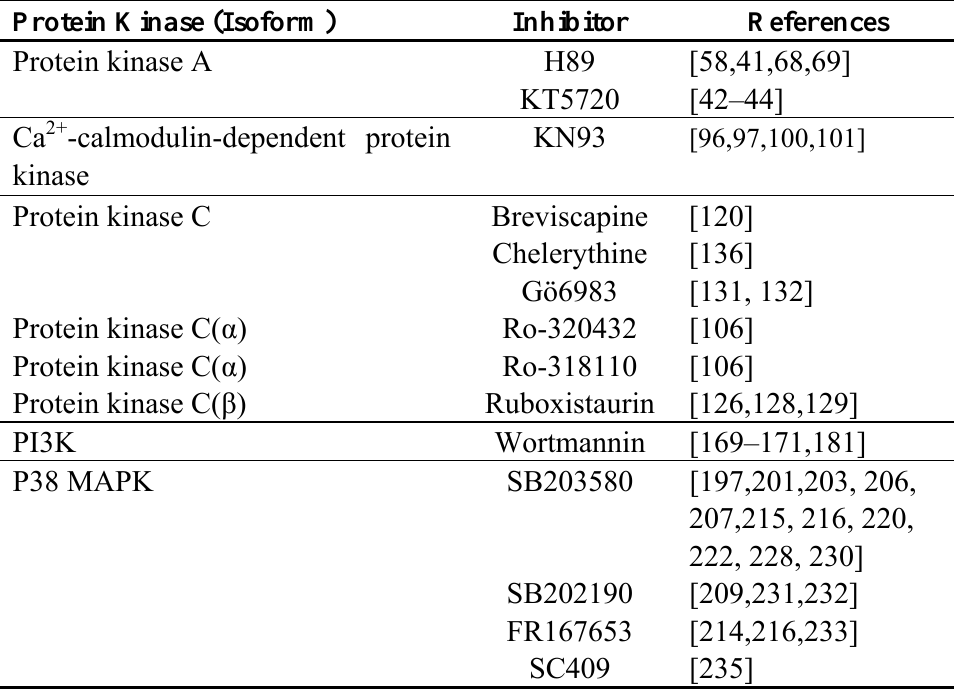
Table 2. Protein kinases and their